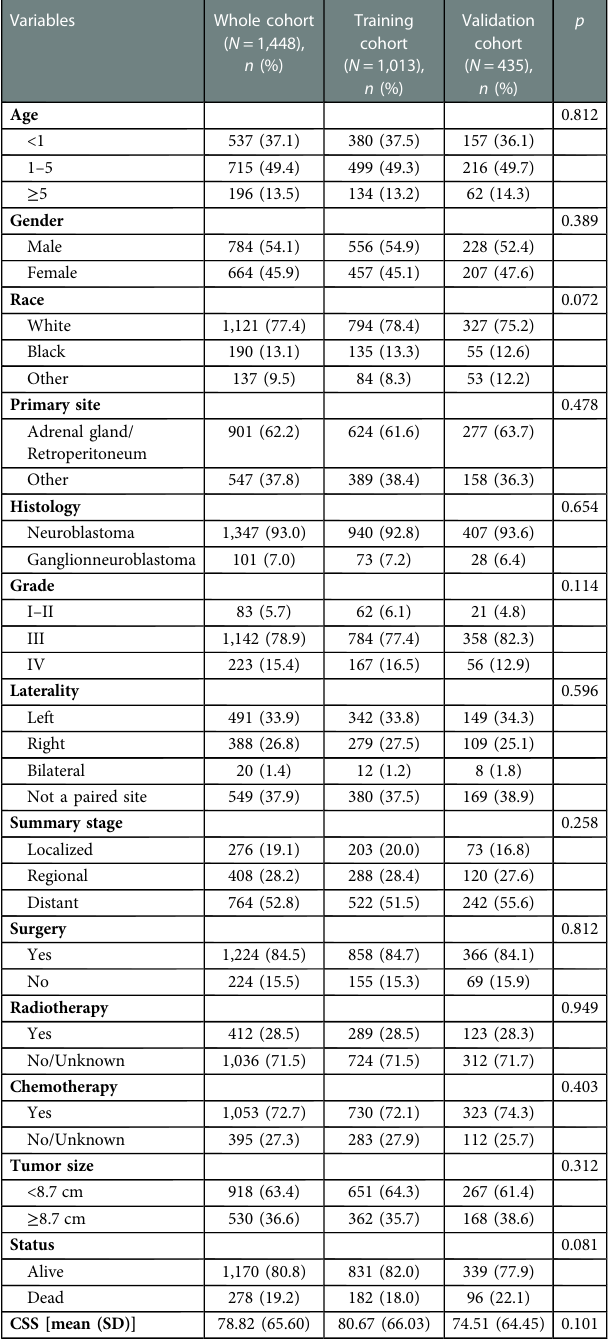
TABLE 1 Demographic characteristics and clinicopathological features of 1,448 NB patients.